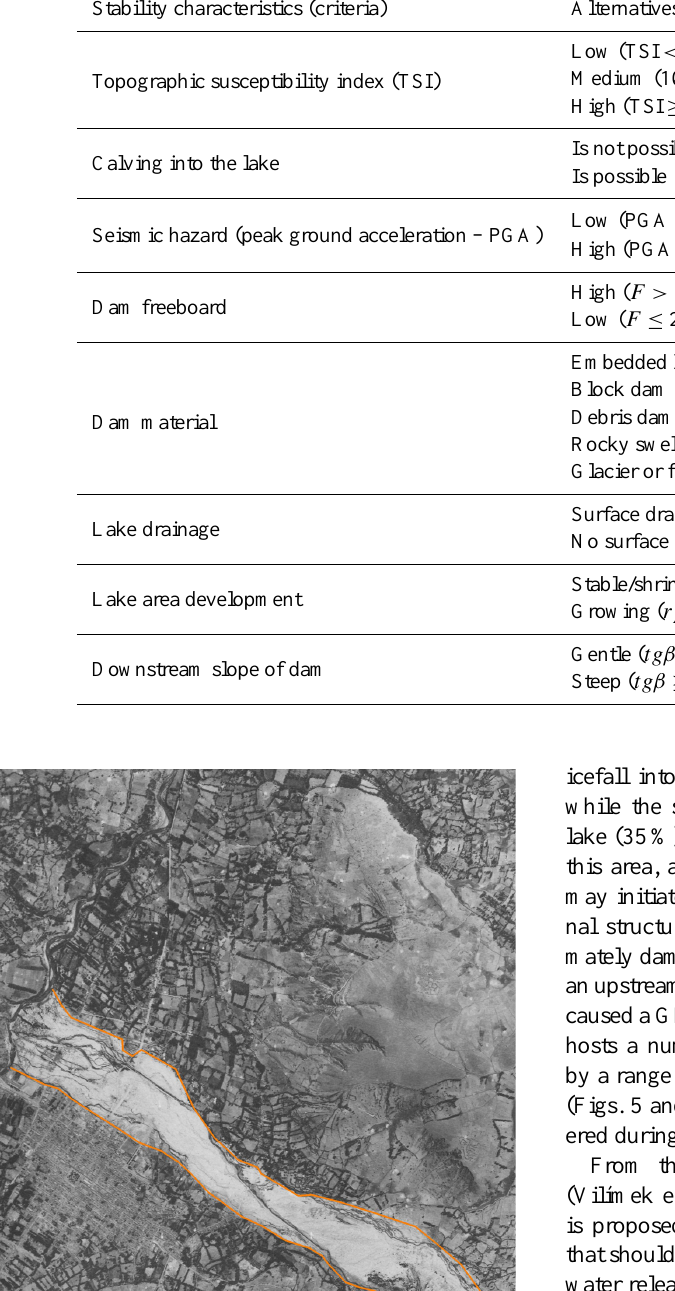
Table 8. The assessed stability characteristics and their critical values defined by Mergili and Schneider (2011). Stability characteristics (criteria) Alternatives and critical values